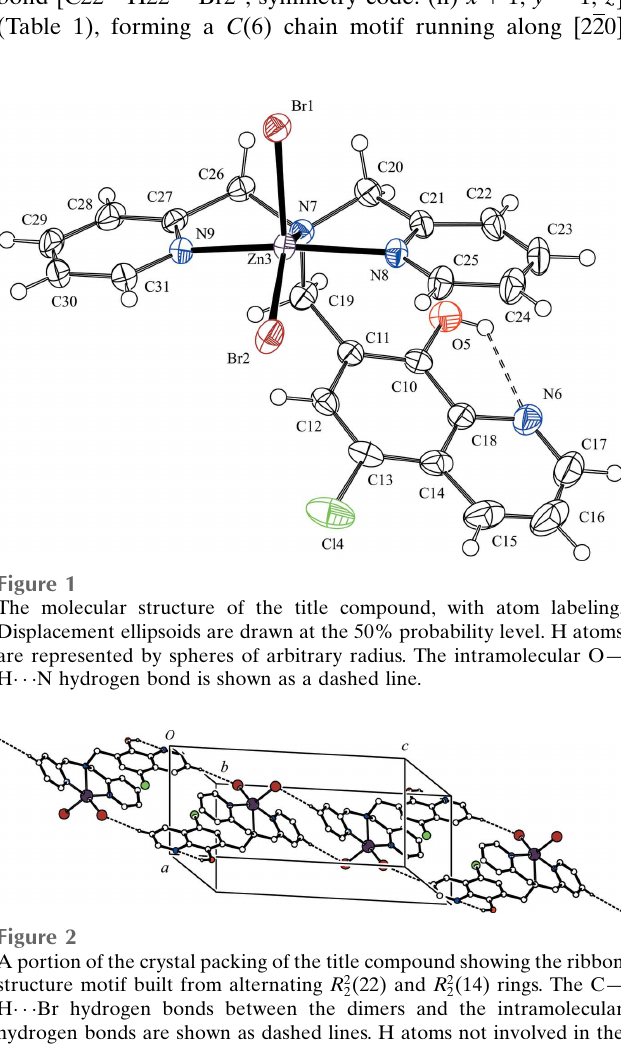
(Table 1), forming a C (6) chain motif running along [220]